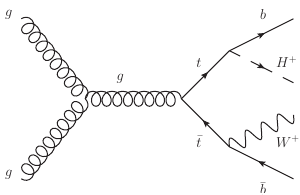
Fig. 1. Feynman diagram of the charged Higgs boson production in t ¯ t